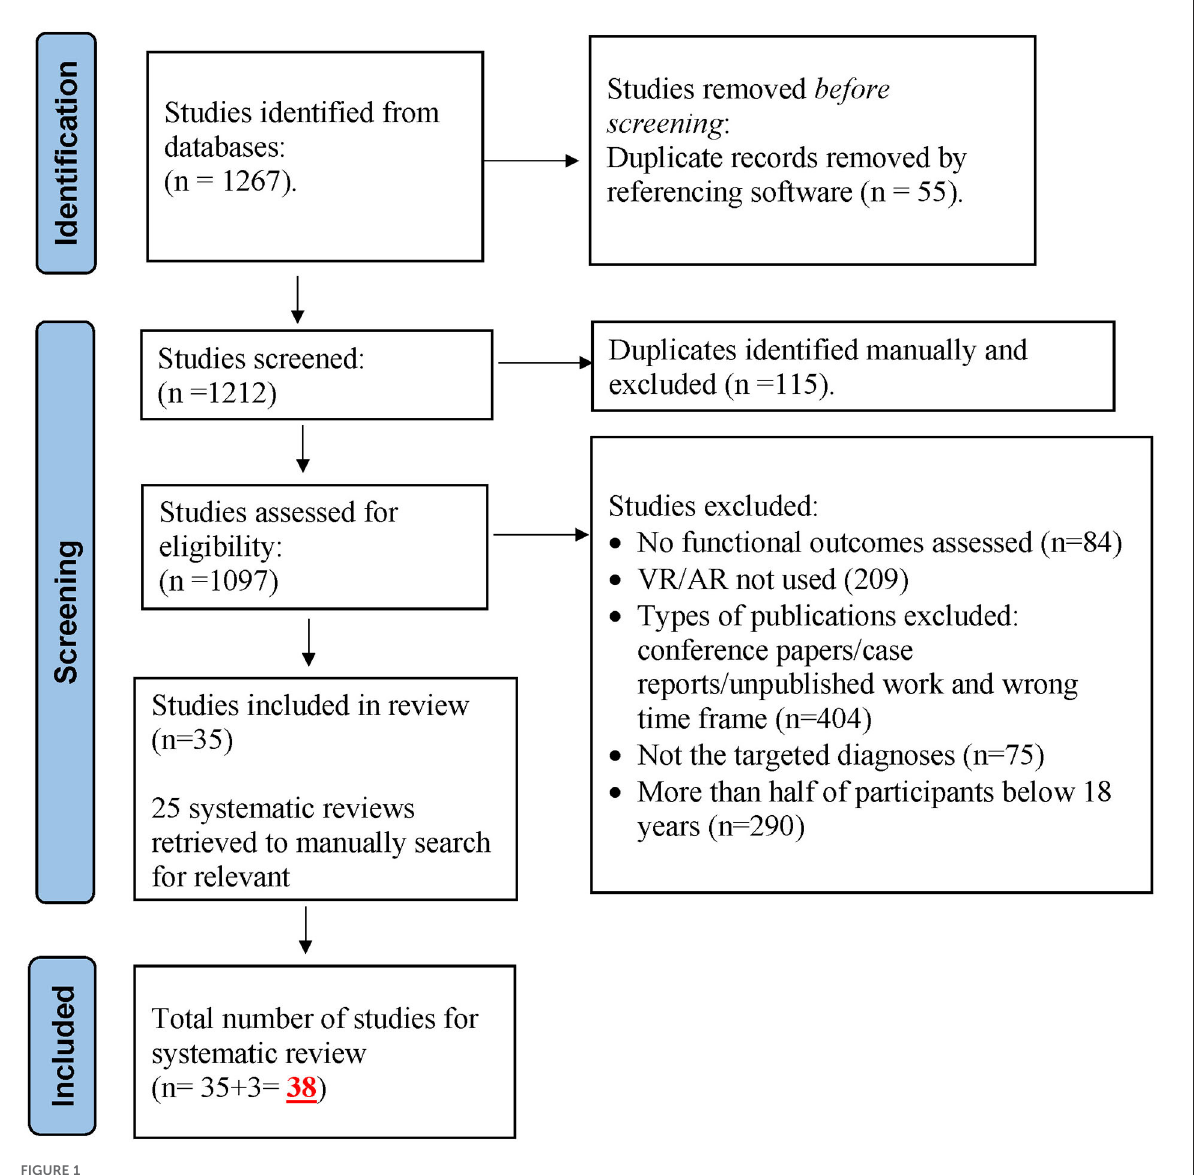
FIGURE1 PRISMA flow